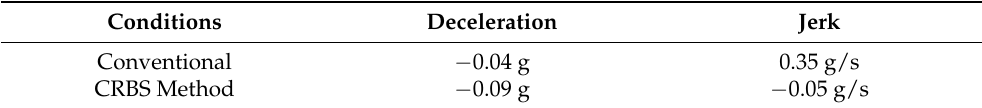
Figure 21. Jerk comparison when changing speed from 30 to 15 km/h. The maximum jerk controlled by CRBS was − 0.05 g/s, and that of the conventional method was 0.35 g/s. Table 2. Comparison of the conventional and CRBS method when vehicle decelerated from 30 km/h to 15 km/h.